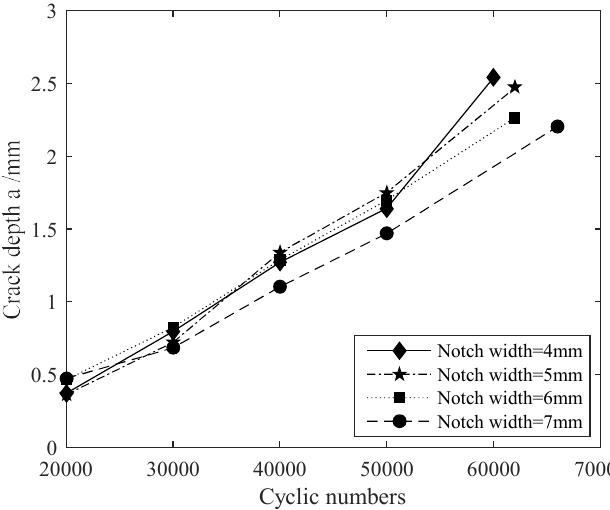
Figure 22. Variation of crack depth with cyclic numbers.